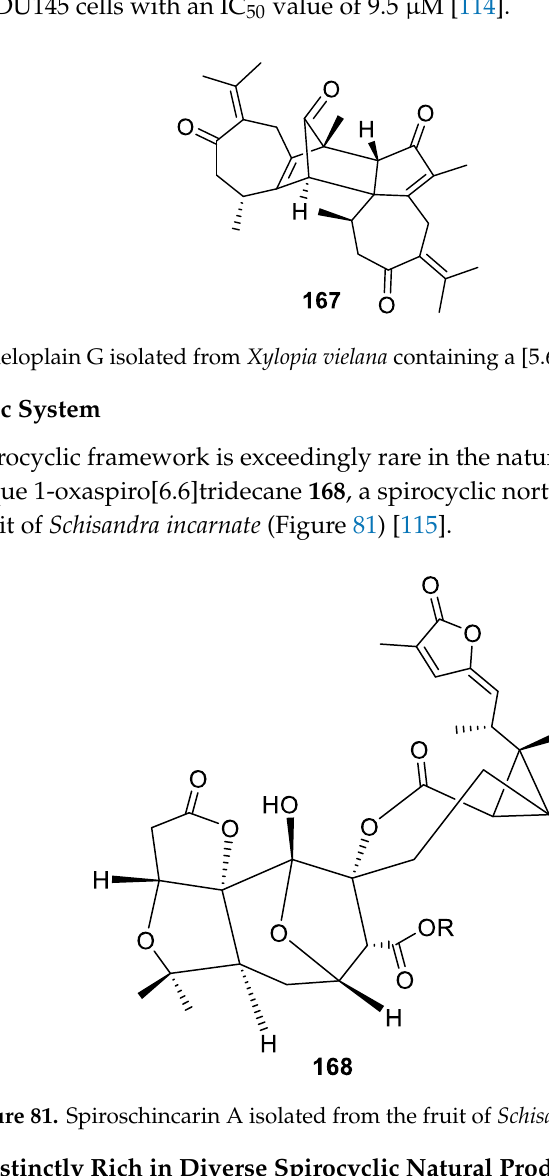
Figure 81. Spiroschincarin A isolated from the fruit of Schisandra incarnate.